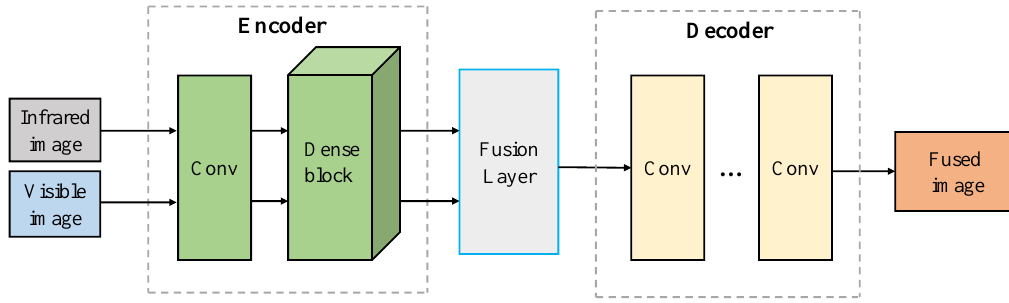
Figure 5. Autoencoder based infrared and visible image fusion framework (credit to [53]).